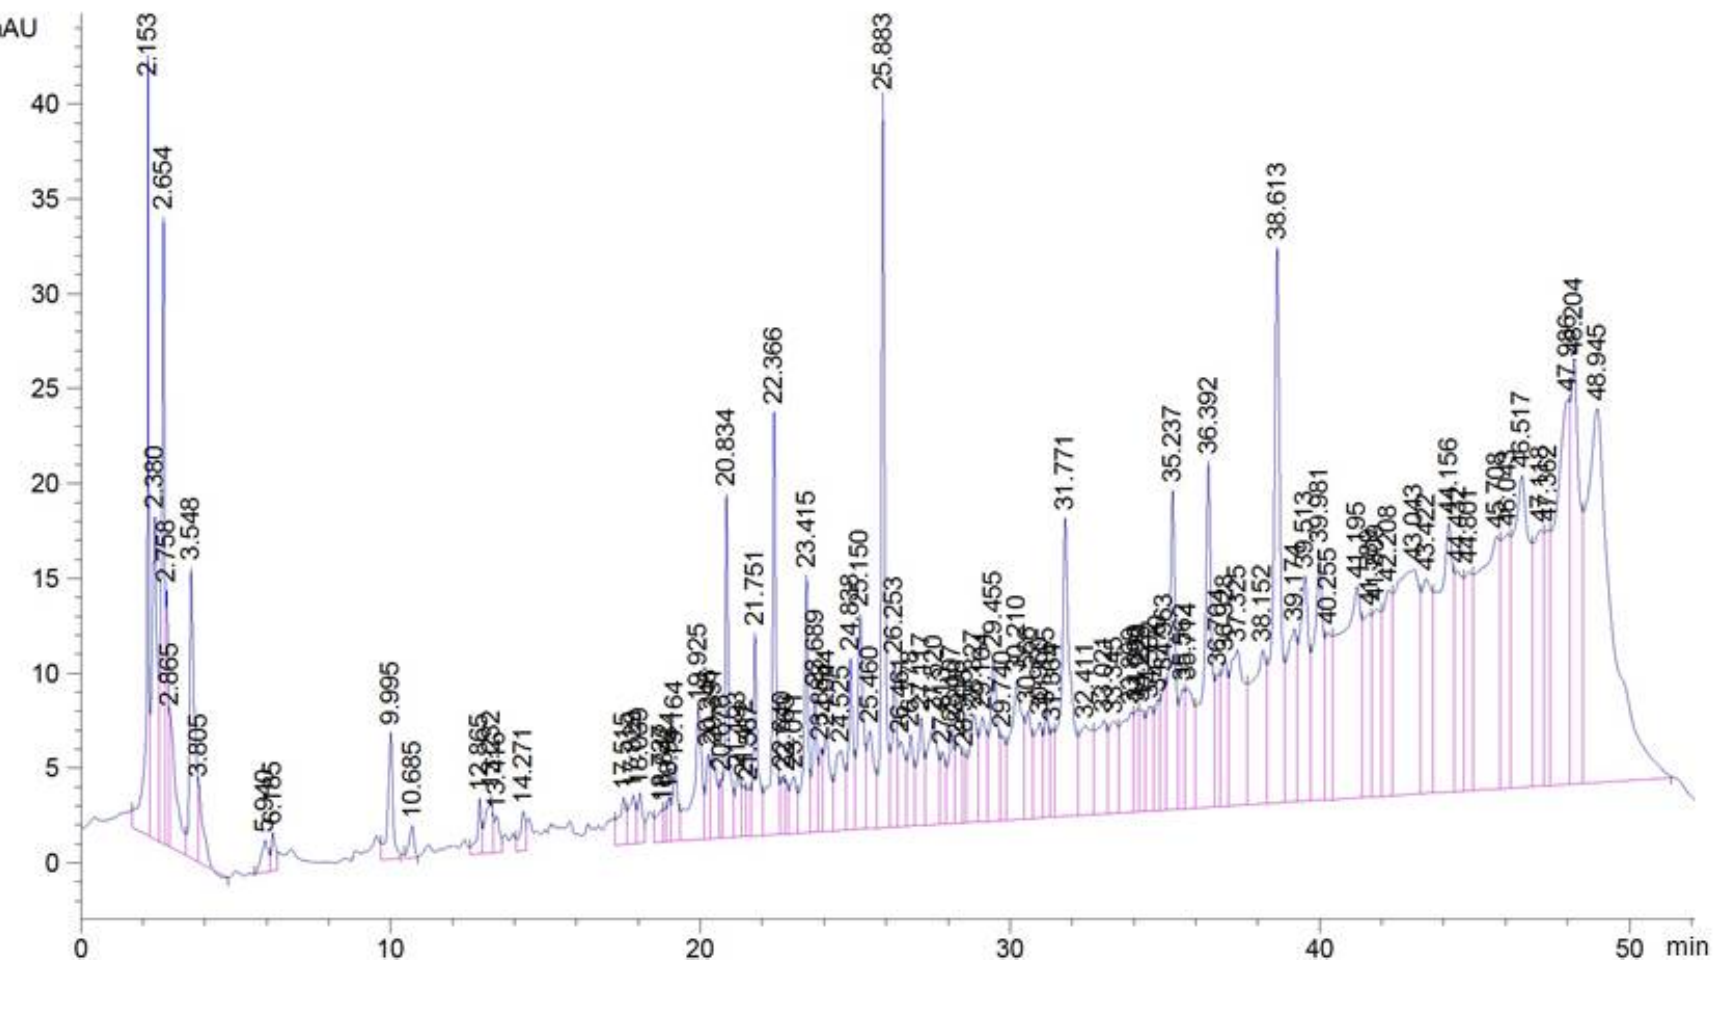
Figure 13. HPLC chromatograms of phenolic extracts from the barks of H. zenkeri recorded at 280 nm (TR: 19.10: 3,4-OH benzoic acid; 33.49:apigenin; 25.67: caffeic acid; 23.48: catechine; 29.43: eugenol; 14.38; gallic acid; 25.11: O -coumaric; 21.91:OH-tyrosol; 30.52: P -coumaric acid. 42.19: quercetin; 29.45: rutin; 25.55: syringic acid; 17.35: theobromine; 21.77: tyrosol and 25.27: vanillic